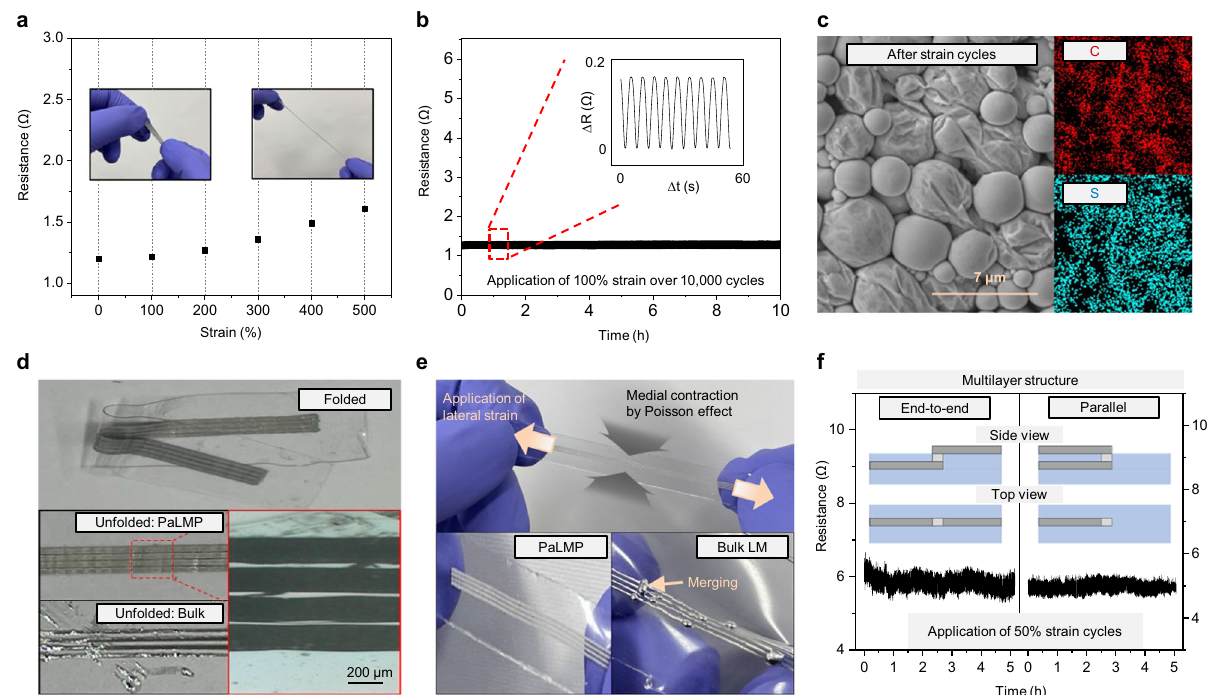
Fig. 5 Characterization of PaLMP. a Resistance of printed PaLMP according to applied strain. b Resistance of PaLMP under repeated application of 100% strain over 10,000 cycles. c SEM image and EDS mapping of PaLMP after the strain cycles. There is no rupturing in PaLMP, and carbon and surfer contained in PSS are uniformly distributed after the cycling. d Top: photograph of folded PaLMP. Middle left, bottom right: photograph and OM images after unfolding of folded PaLMP, respectively. Bottom left: photograph after unfolding of folded bulk LM. e Top: photograph of stretched PaLMP. Bottom: images of PaLMP (left) and bulk LM (right) after stretching. f Resistance variation of multilayered PaLMP-based interconnects under repeated application of 50% strain. Inset: illustration of end-to-end (left) and parallel (right) electrodes con fi